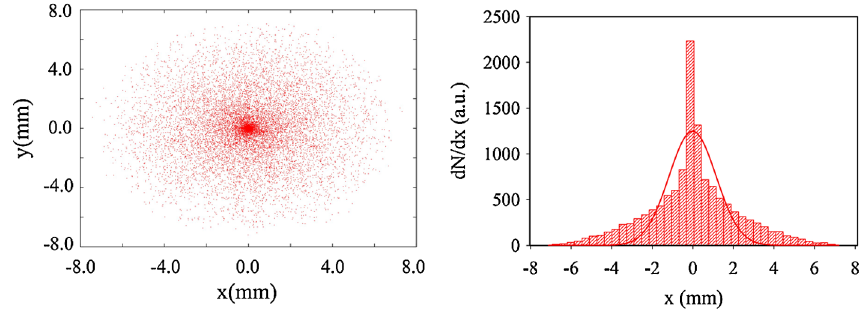
FIG. 14. Transversal proton distribution for the energy band 10 MeV (cid:2) 0 : 5 MeV after 460